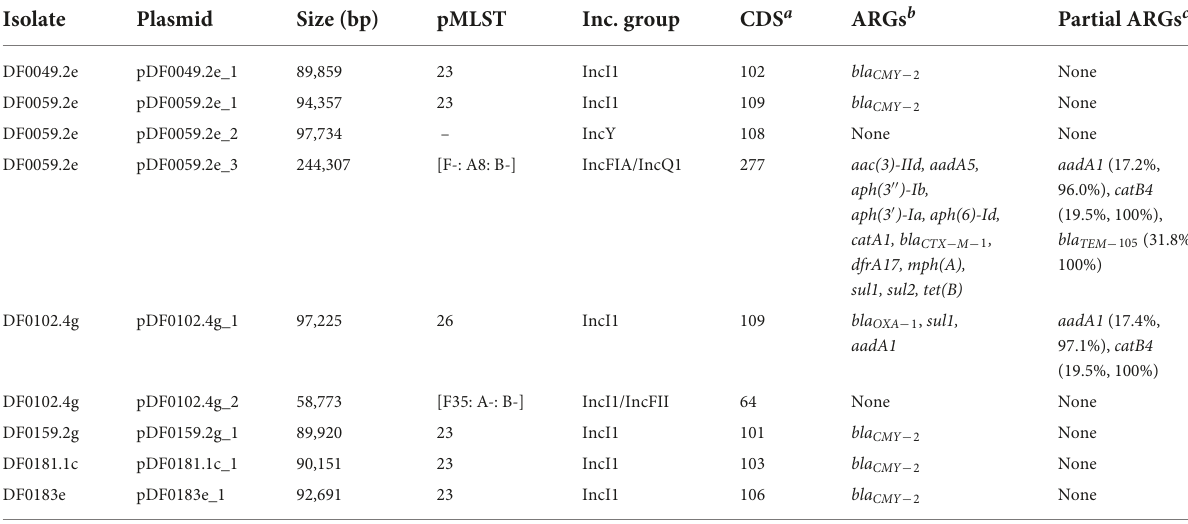
TABLE 5 Characteristics of plasmids from E. coli sequenced with short-read Illumina and long-read MinION